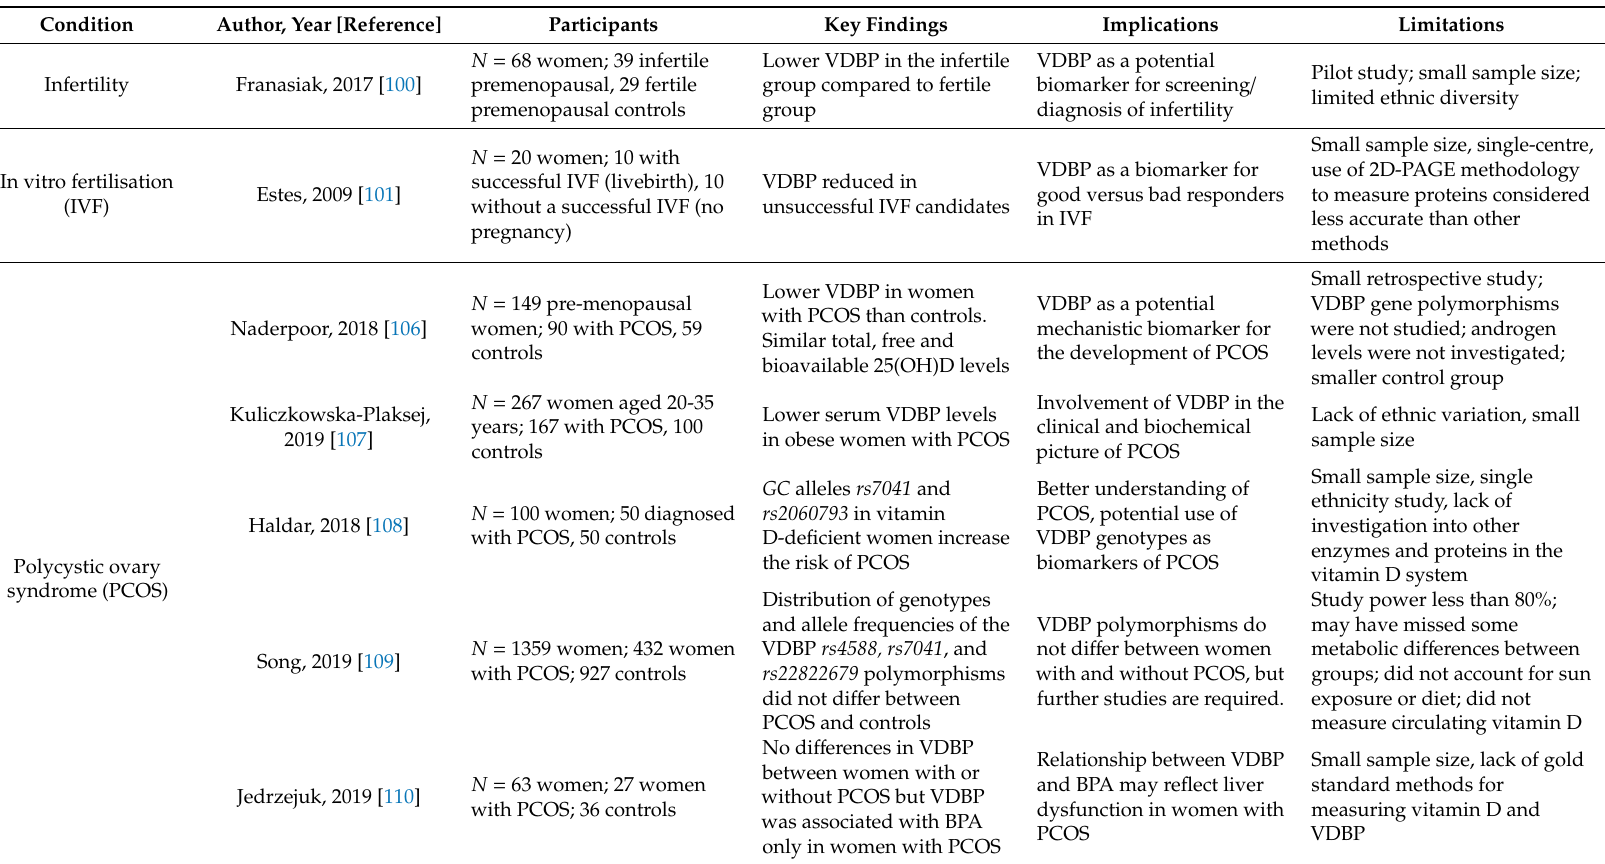
Table 3. Summary of studies examining vitamin D-binding protein in relation to fertility and pregnancy-related